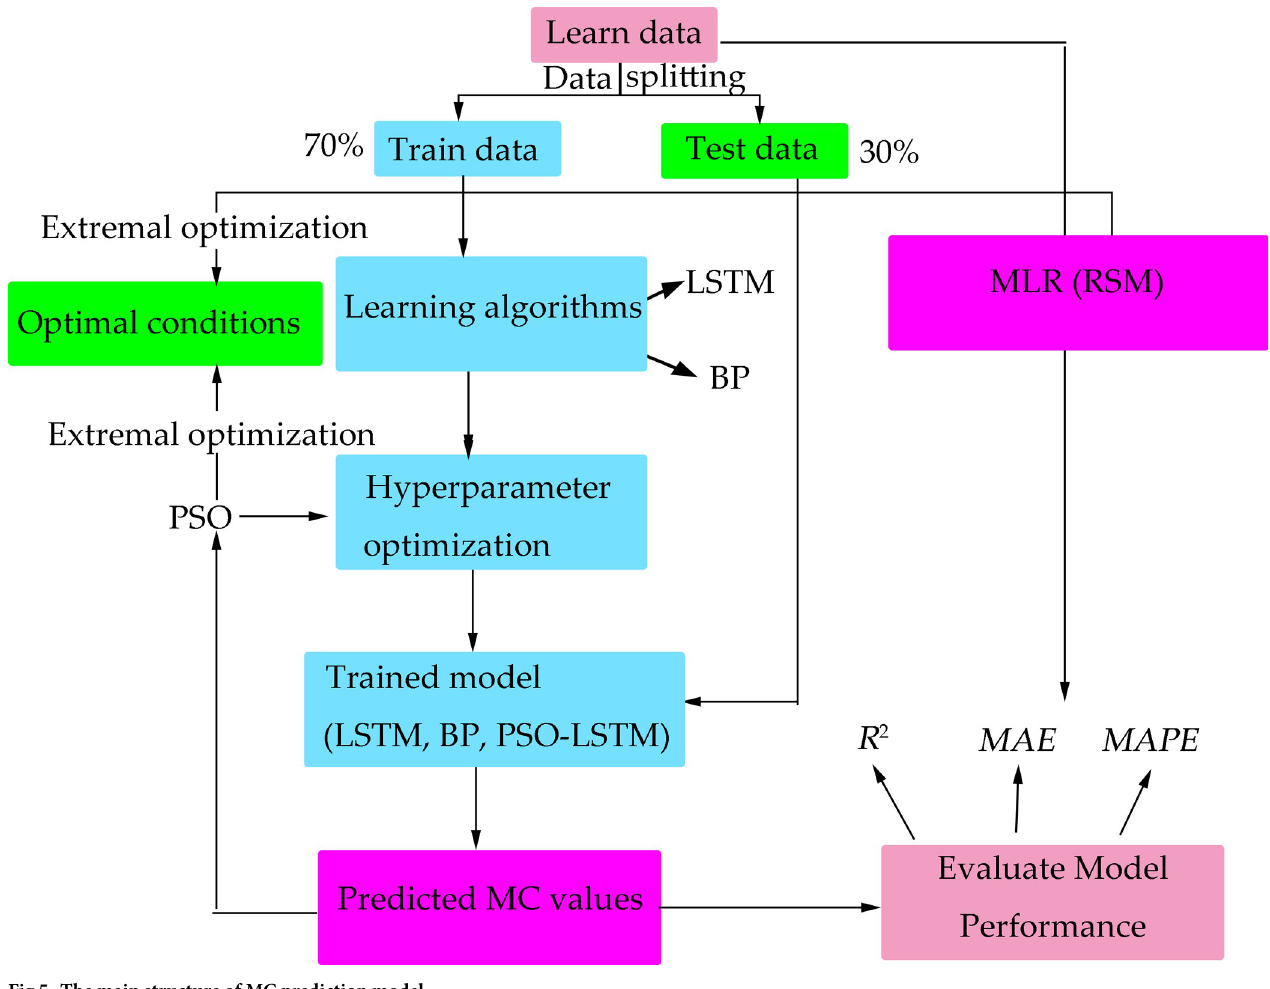
Fig 5. The main structure of MC prediction model.